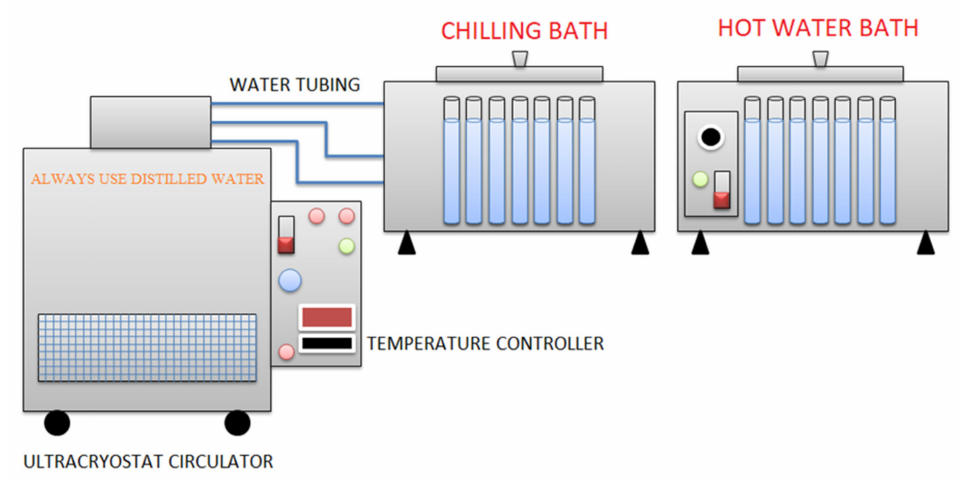
Figure 2. The model description of the thermal cycle testing